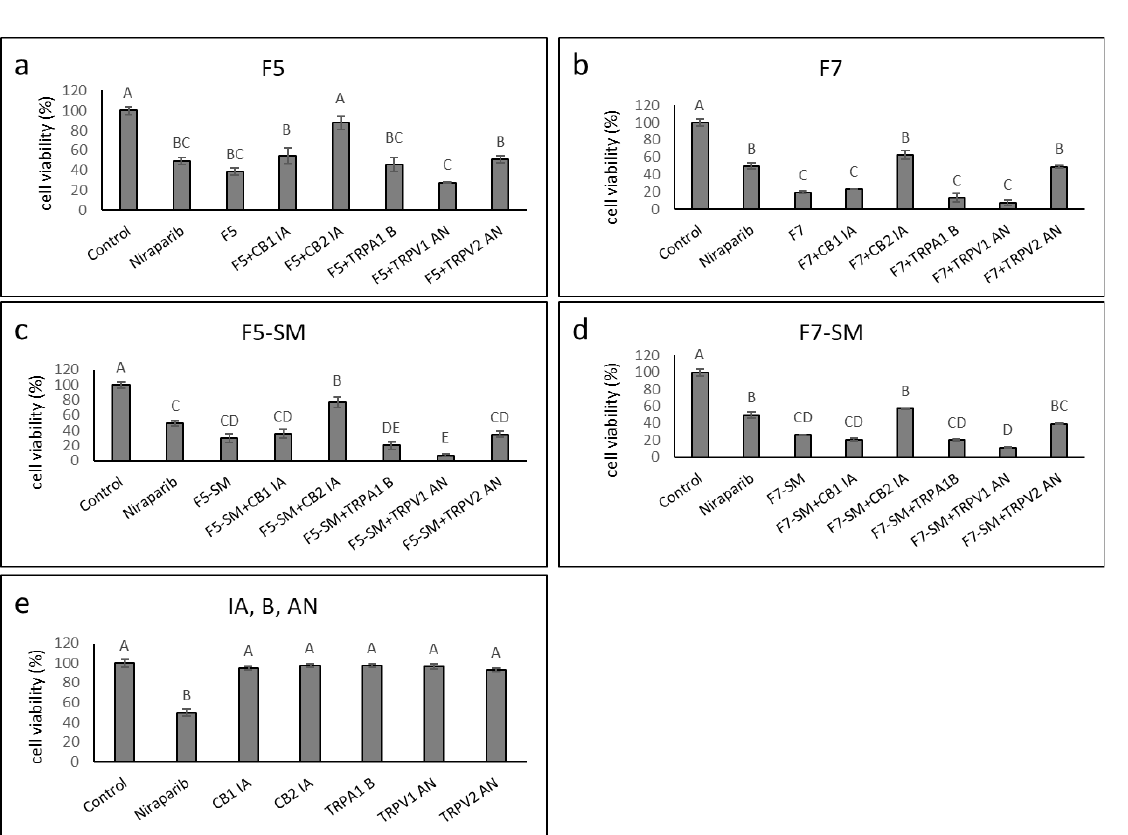
Table 1. Quantitative PCR determination of the RNA steady state level in the HTB75 cell line of CB2 receptor ( CNR2 ) or TRPV2 genes, after treatment with F5 or F7 for 6 h relative to control. Treatment